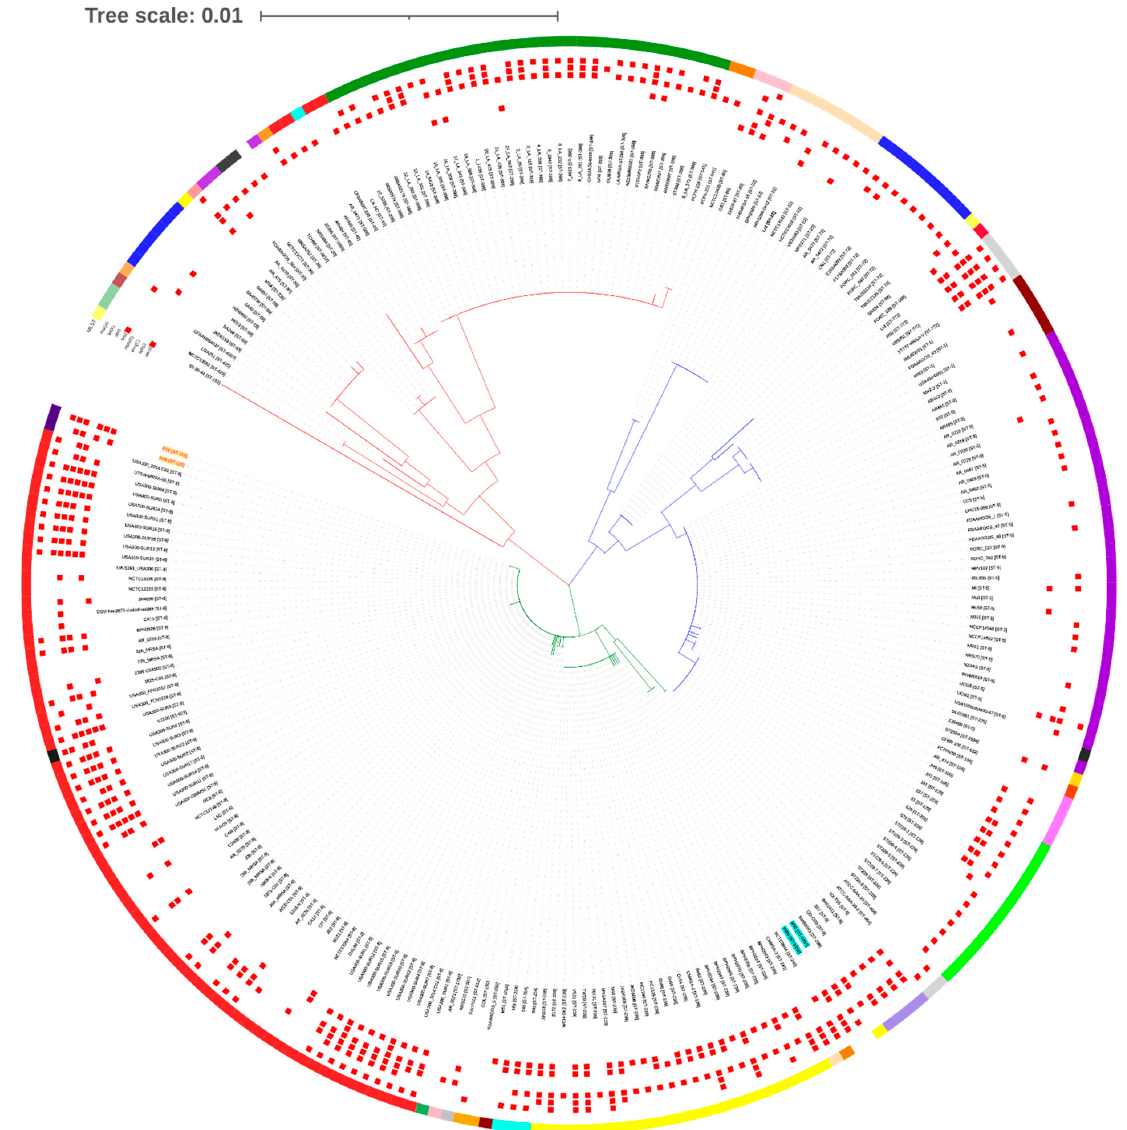
Figure 2. A Maximum Likelihood tree based on variations in housekeeping genes ( arcC , aroE , glpF , gmk , pta , tpi , and yqi ) of the 254 (test strains n = 2, global strains n = 252) MRSA genomes. The evolutionary history was inferred by using the Maximum Likelihood method and the General Time Reversible model. The tree is drawn to scale, with branch lengths measured in the number of substitutions per site. The tree also shows sequence type (ST) assignment and antibiotic resistance genes. The test strains are highlighted in red, boldfaced, and yellow background. The strains (M92 and V605) for which new ST numbers (ST-5354, and ST-5355) were assigned are boldfaced and highlighted in blue background. The rectangular tree is given in Additional file 1 for better presentation.